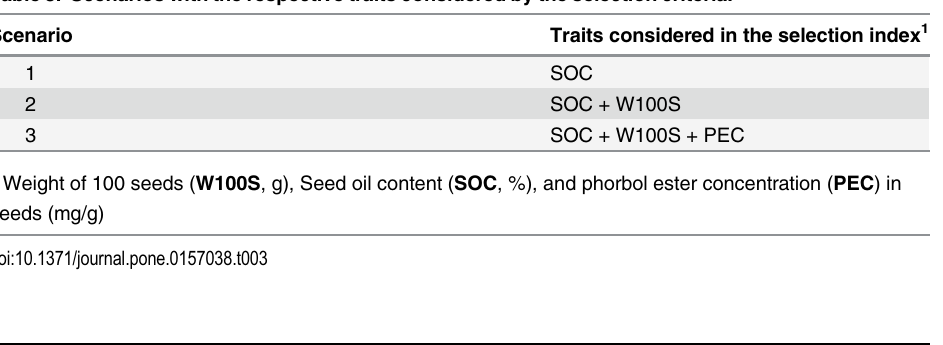
Table 3. Scenarios with the respective traits considered by the selection